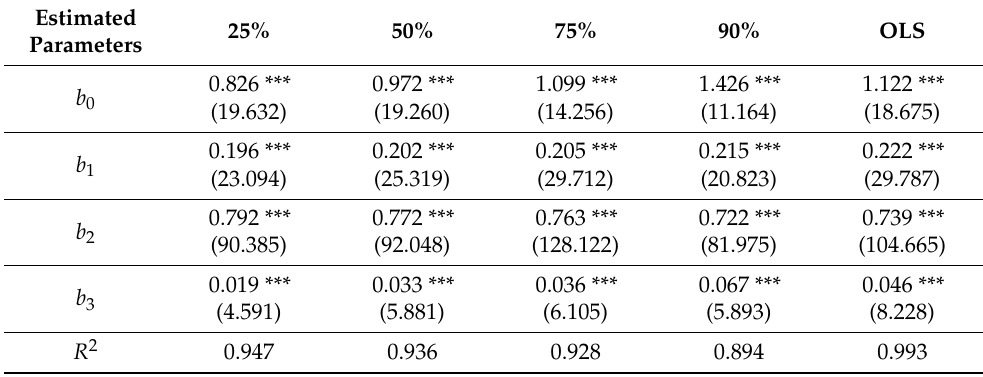
Table 8. Regression Results for Operating